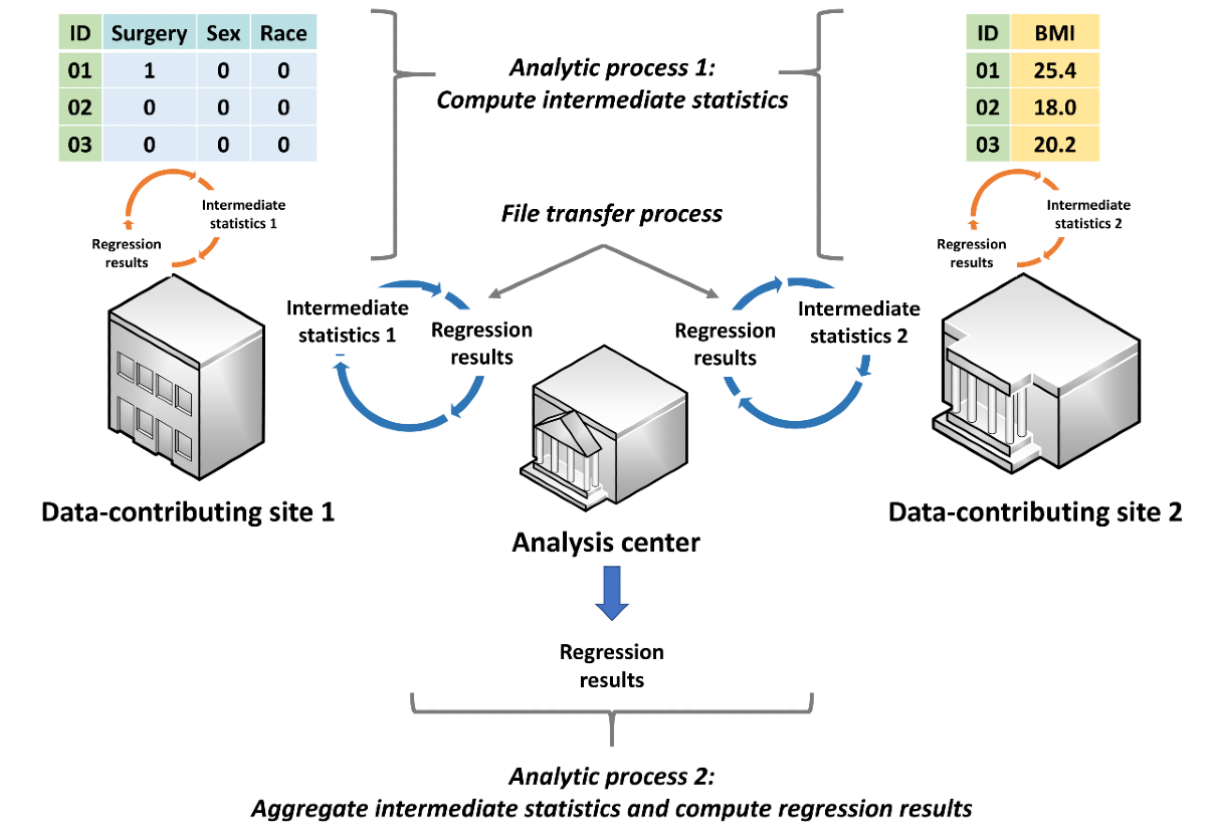
Figure 2. Distributed regression analysis in vertically partitioned data environments. In this hypothetical example, surgery, sex, and race are the independent variables, while BMI is the dependent variable. Data-contributing site 1 has data on the independent variables, while data-contributing site 2 has data on the dependent variable. Data-contributing site 2 can also have additional independent variables, as another variant of vertically partitioned data